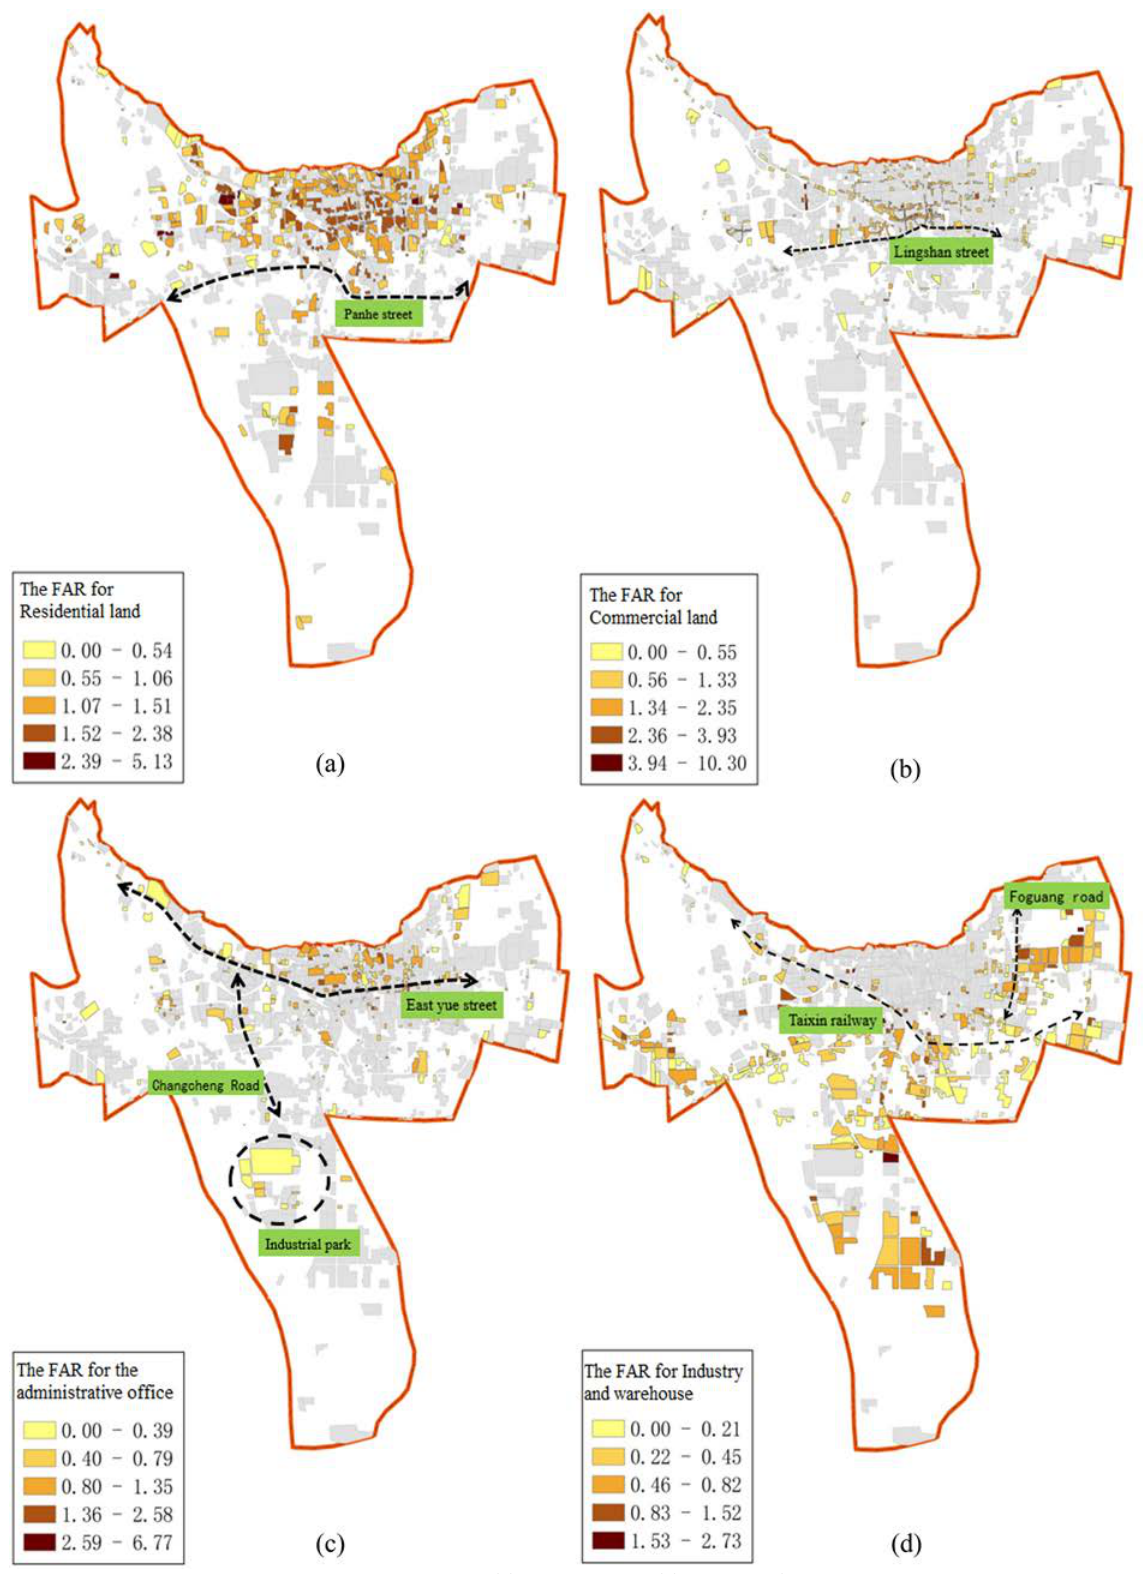
Figure 3. Spatial visualization of floor area ratio of four types of construction